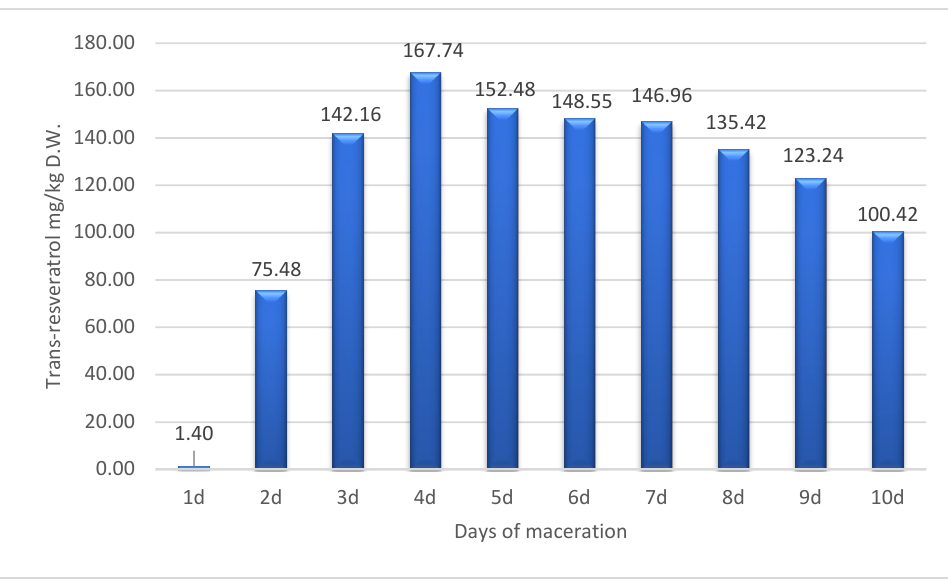
Figure 4. Extraction yield of resveratrol for different granulosity of the powdered material of vine shoots.